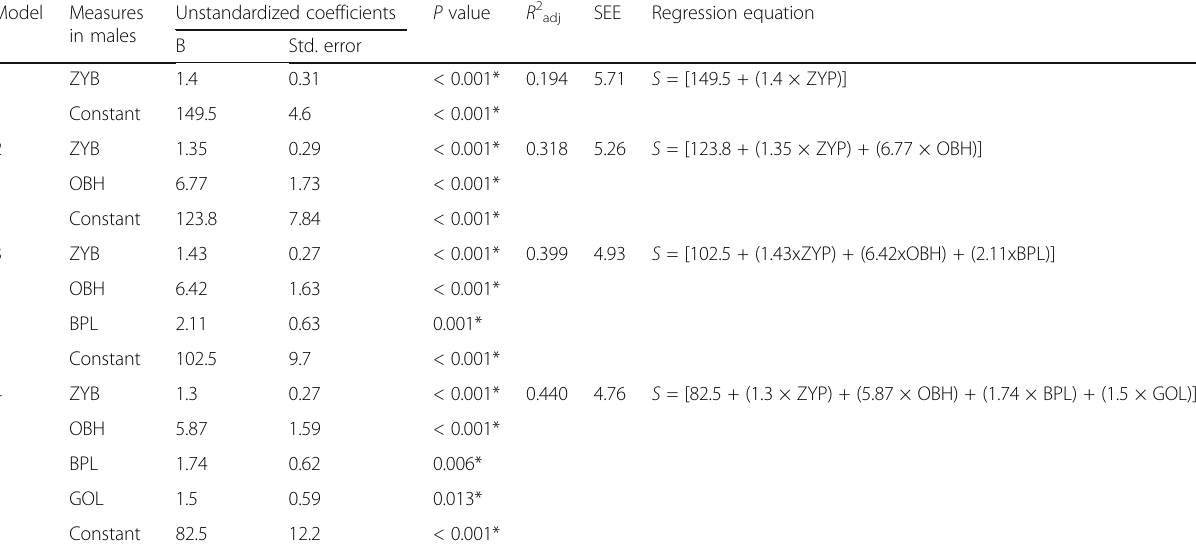
Table 10 Multiple stepwise linear regression analysis of skull measurements for stature estimation in males ( n = 80) Model Measures in males